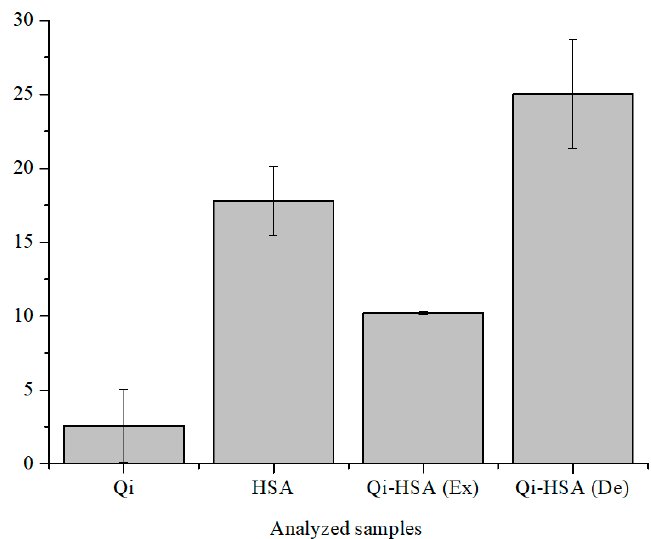
Figure 3. The value of % inhibition of Qi ([Qi] = 7 × 10 − 5 M), HSA ([HSA] = 2.8 × 10 − 4 M) and Qi- HSA complex (1:4 molar ratio; [Qi] = 7 × 10 − 5 M; [HSA] = 2.8 × 10 − 4 M); Ex: expected, De: designated (DPPH assay); pH=7.4.